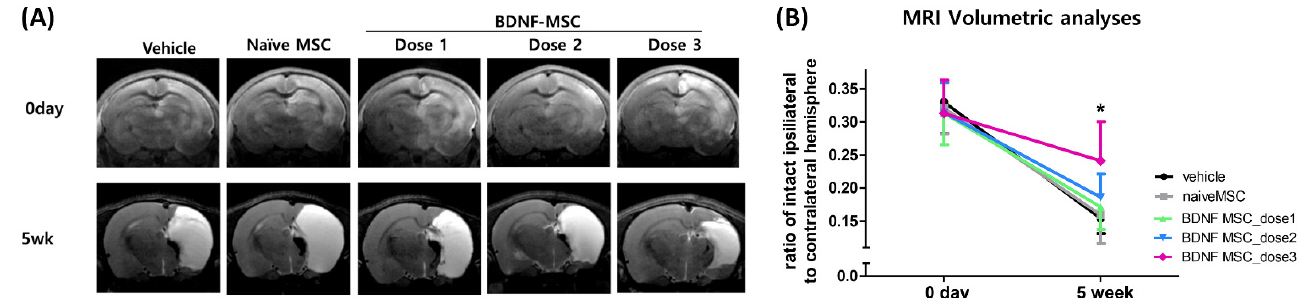
Figure 5. Brain damage area after hypoxic ischemic injury and MSC transplantation. ( A ) Representative serial brain magnetic resonance imaging (MRIs) from each group at right after HI brain injury modeling and 5 weeks after modeling. ( B ) The volumetric ratio of intact ipsilateral hemisphere to contralateral hemisphere was volumetrically evaluated in the serial images of brain MRI in each group right after HI brain injury modeling and 5 weeks after modeling. Data are expressed as mean ± standard error of the mean. * p < 0.05 compared to the HI + vehicle control. Abbreviations: vehicle, HI + vehicle control, naïve MSCs; HI + naïve MSCs, BDNF MSC_dose1; HI + BDNF-eMSCs at 1 × 10 4 cells dose; BDNF MSC_dose2; HI + BDNF-eMSCs at 5 × 10 4 cells dose; BDNF MSC_dose3; HI + BDNF-eMSCs at 1 × 10 5 cells